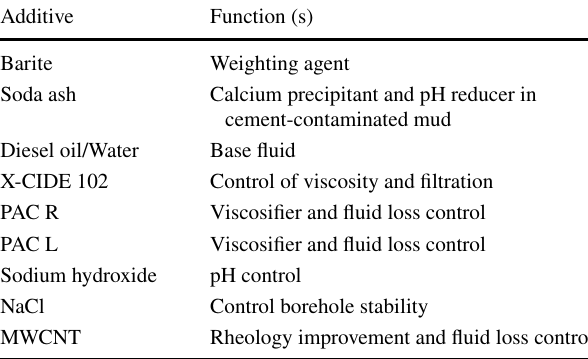
Table 1 Mud additives and their